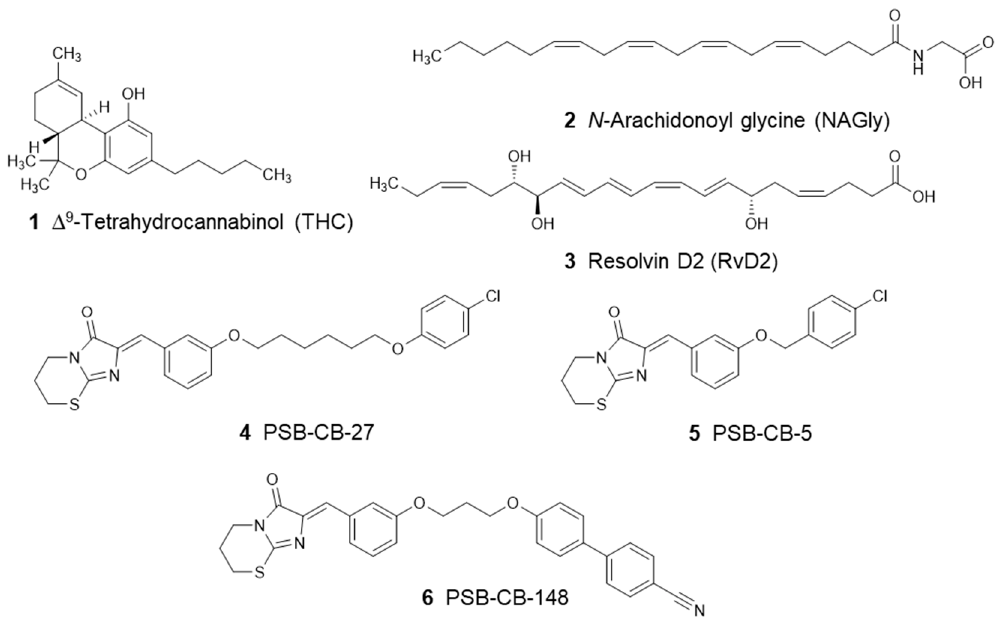
Figure 1. Structures of proposed GPR18 agonists ( 1 – 3 ) and antagonists ( 4 – 6 ).